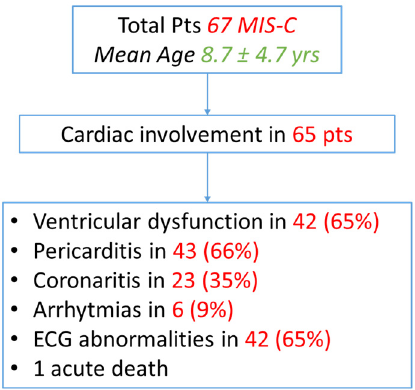
Figure 1. Flow chart of cardiac involvement in MIS-C patients. Table 1. MISC patients with cardiac involvement in follow-up. Follow-up Duration